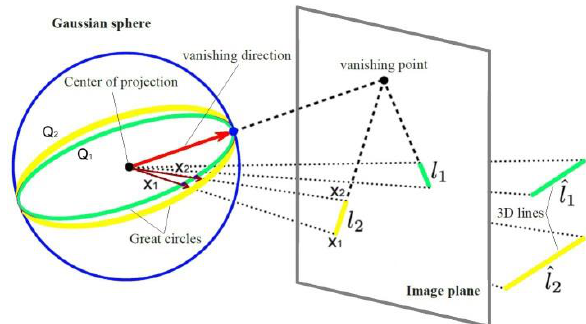
Figure 4. Imaged line segments l 1 , l 2 of 3D parallel lines intersect at a vanishing point on the image plane. The same vanishing point can be parametrized as a vector